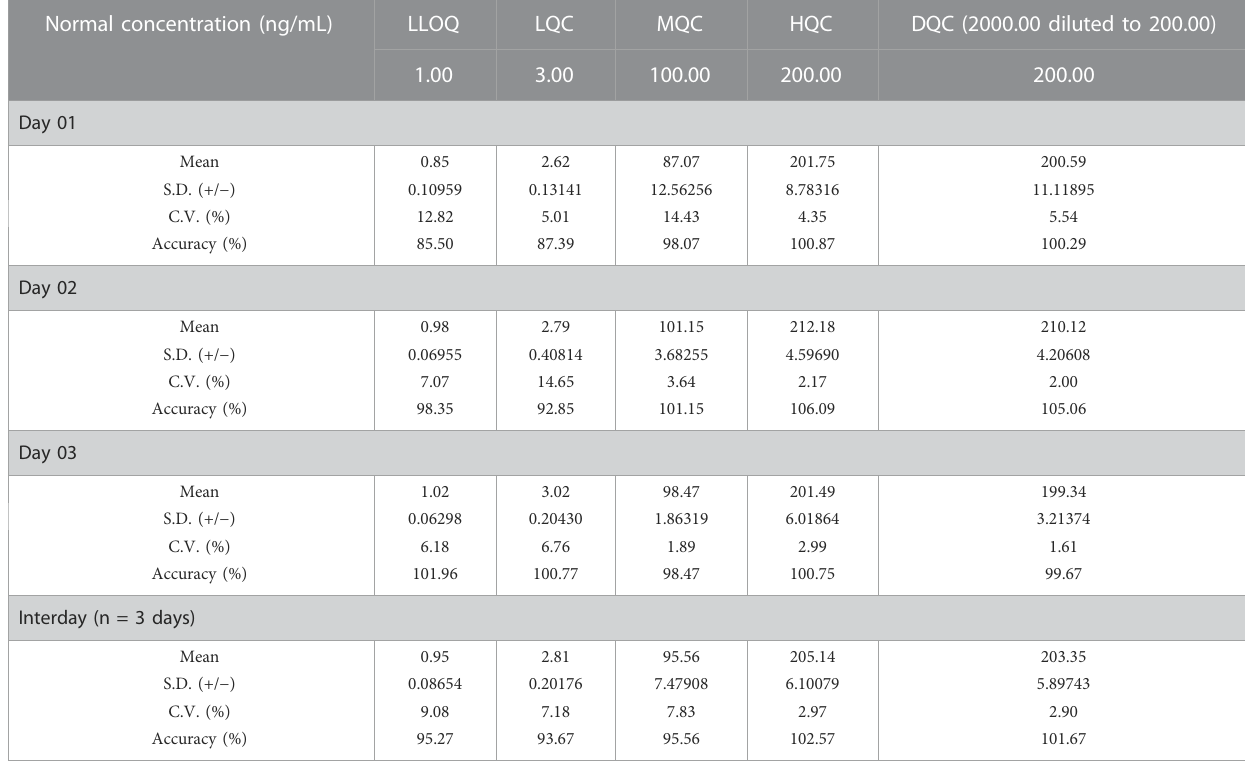
TABLE 1 Precision and accuracy for intraday and interday. Normal concentration (ng/mL)